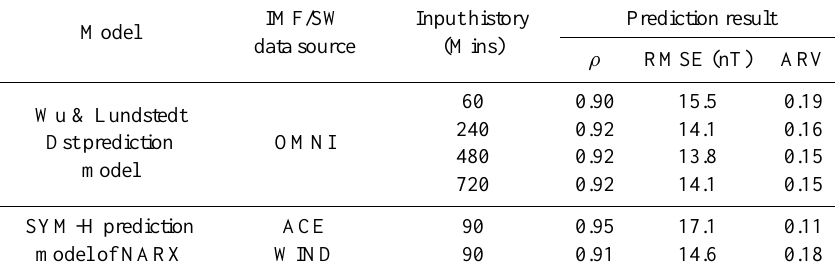
Table 5. Comparison of Dst prediction by Elman network with SYM-H by NARX